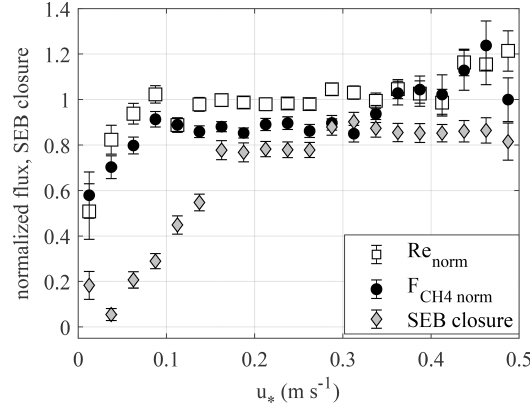
Figure A1. Bin-median values of CO 2 respiration (Re) and CH 4 ef- flux, normalized by their temperature-based statistical models, and surface energy balance closure (SEBC = (H + LE )/Rn ) vs. friction velocity for May–October, with the bars giving SD of the